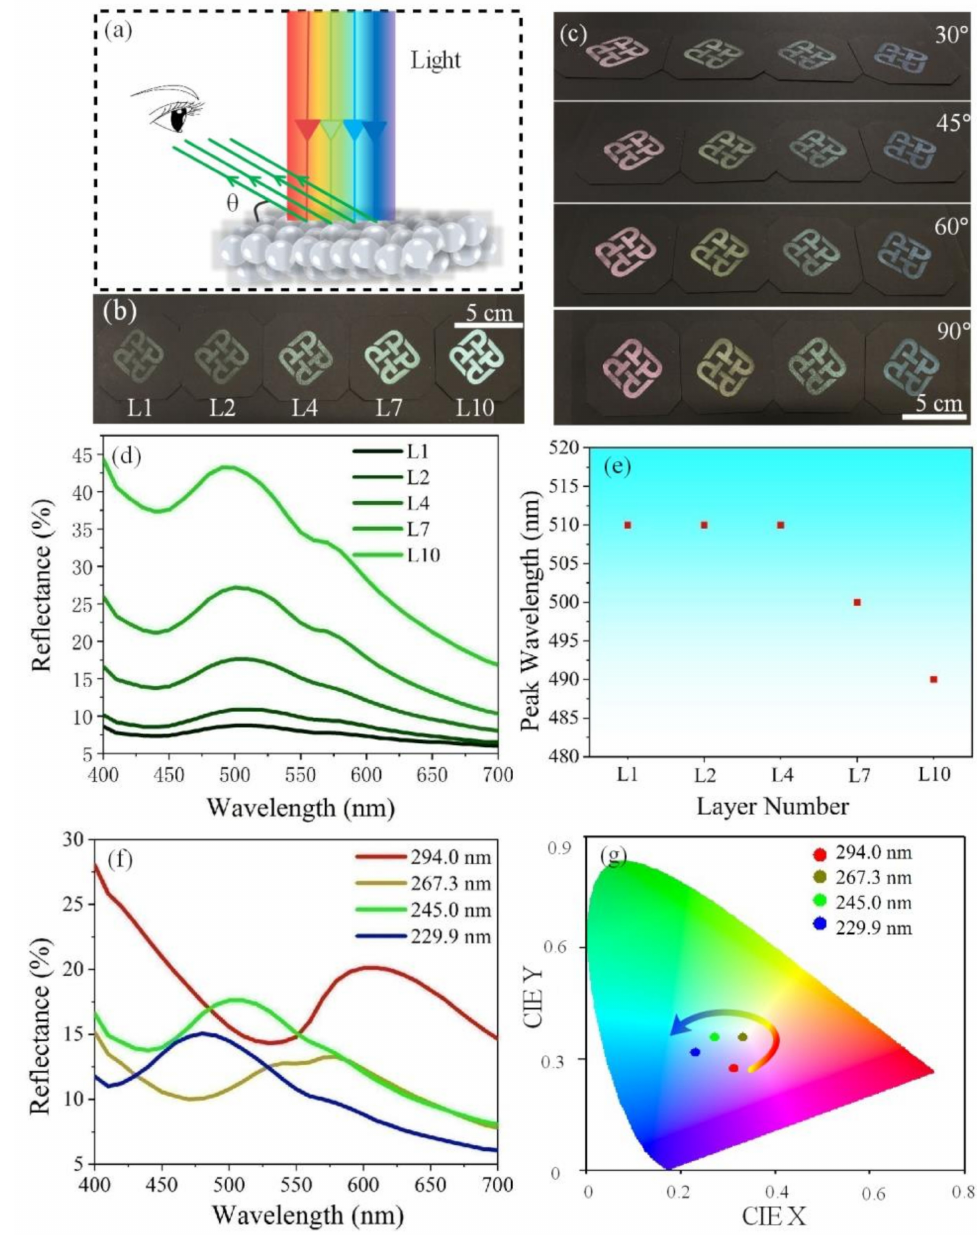
Figure 3. ( a ) Schematic representation of structural color observation with viewing angle ( θ ). ( b ) Photographs of SiO 2 PSPs (245 nm) coated PolyU logo patterns with different thicknesses of PSPs (various spraying layers) from 1 to 10 (L1 to L10). ( c ) Photographs of PolyU logo patterns with four structural colors using SiO 2 PSPs with different SiO 2 NPs sizes from 294.0 nm, 267.3 nm, 245.0 nm to 229.9 nm at different viewing angles (30 ◦ , 45 ◦ , 60 ◦ , 90 ◦ ). ( d , e ) Reflectance spectra and the corresponding maximum reflection peak wavelength of PSPs coated patterns in ( b ). ( f ) Reflectance spectra of the four structural colors in ( c ). ( g ) The CIE chromaticity diagram of the four structural colors in ( c